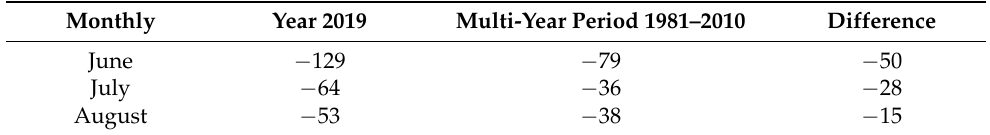
Table 1. Comparison of mean climatic water balance (CWB) values (mm) over Poland in the months June–August in 2019 with values from the 1981–2010 multi-year period.